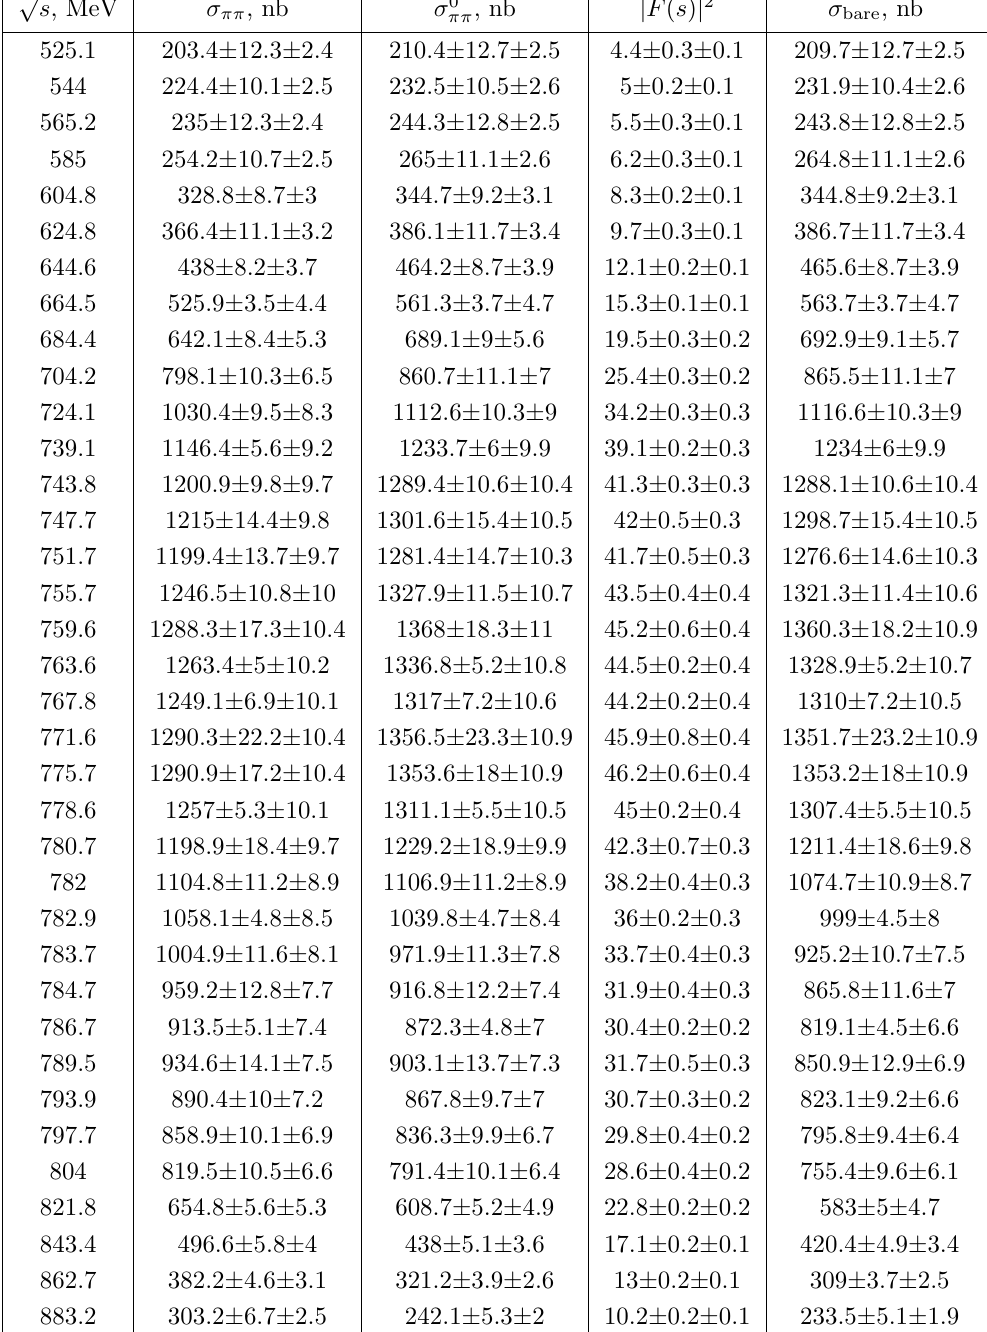
Table 1 . The results of the e + e (cid:0) ! (cid:25) + (cid:25) (cid:0) cross section measurements. (cid:27) (cid:25)(cid:25) , (cid:27) 0 physical, Born cross sections of the process e + e (cid:0) ! (cid:25) + (cid:25) (cid:0) , and pion form factor, calculated with formula in ref. [25]. (cid:27) bare is the e + e (cid:0) ! (cid:25) + (cid:25) (cid:0) undressed cross section without vacuum polarization, but with the (cid:12)nal state radiative correction. Both statistical and systematic errors are shown.